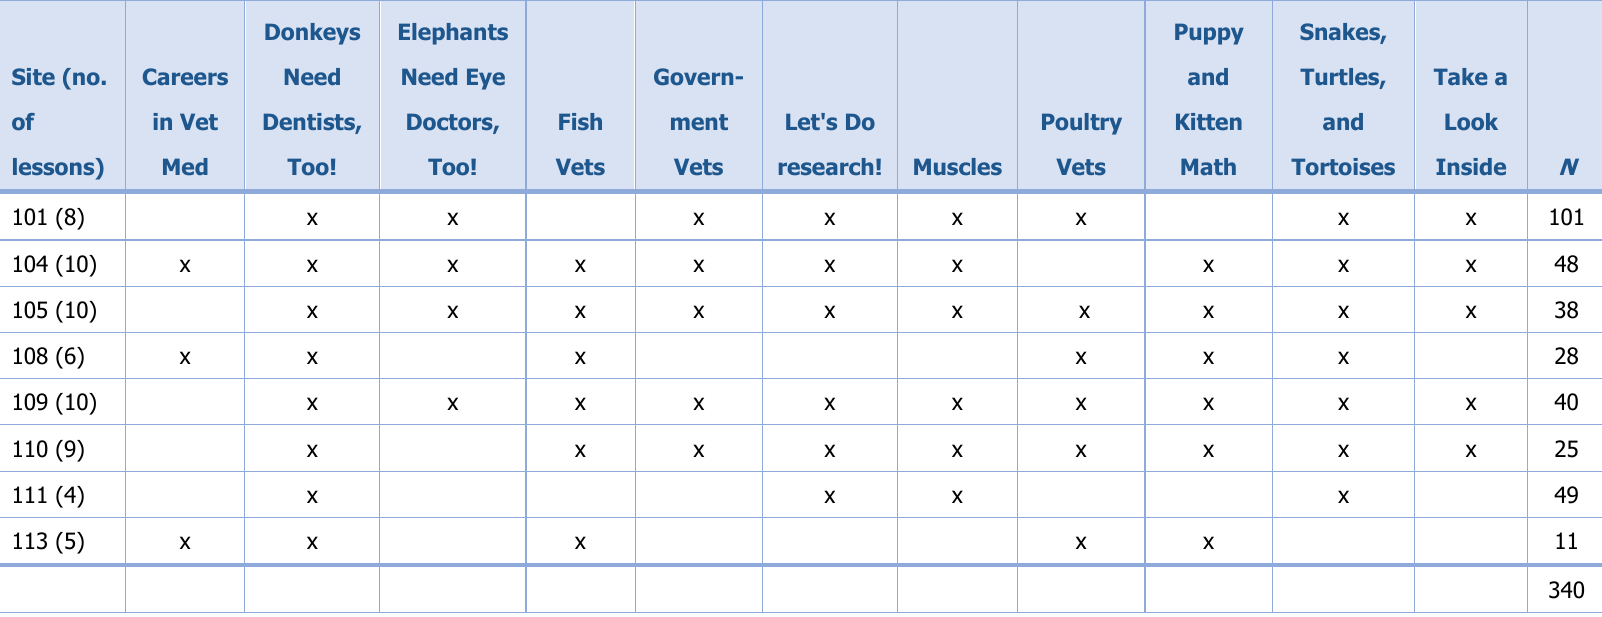
Table 3. Youth and Lessons in Each Site